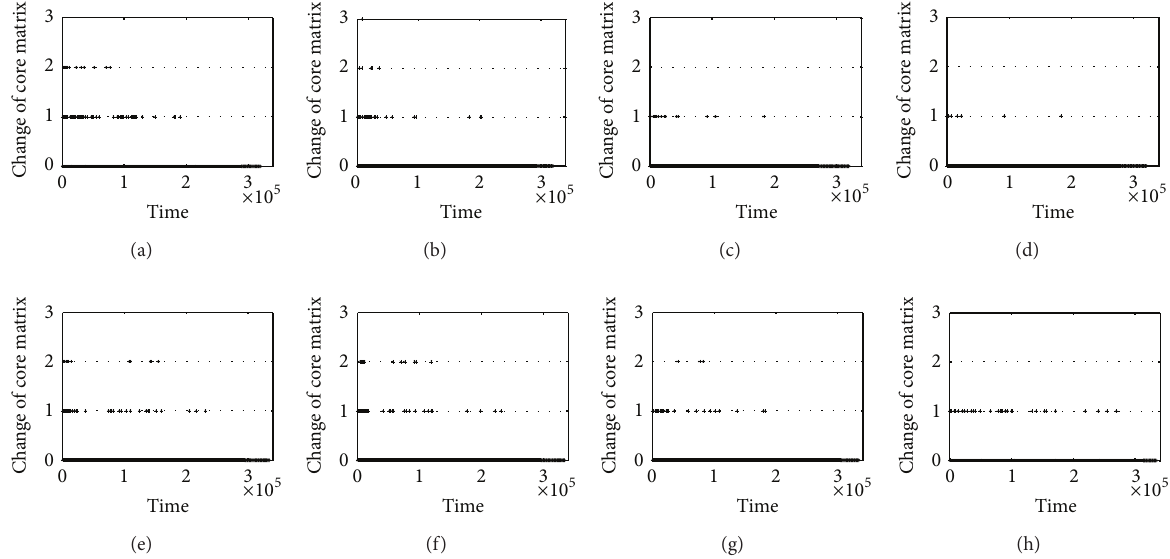
Figure 10: Number of changes in core matrix between two consecutive timestamps. Above: number of changes in SIGCOMM09 under 𝛿 = 0.2, 0.4, 0.6, and 0.8 (from (a) to (d)). Below: number of changes in INFOCOM06 under 𝛿 = 0.2, 0.4, 0.6, and 0.8 (from (e) to